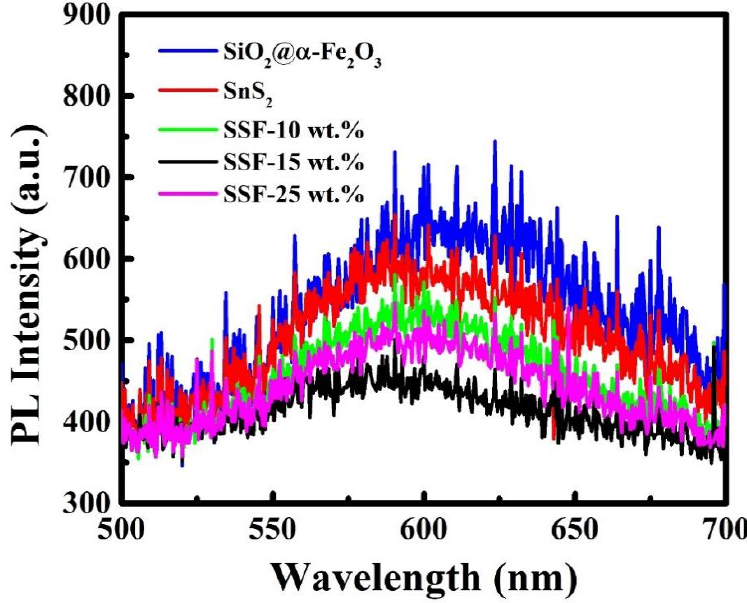
Figure 9. Photoluminescence spectra of SiO 2 @ α -Fe 2 O 3 , SnS 2 , and SnS 2 -SiO 2 @ α -Fe 2 O 3 nanocomposites with different weight percentages (SSF-X) (X = 10, 15, and 25 wt %).